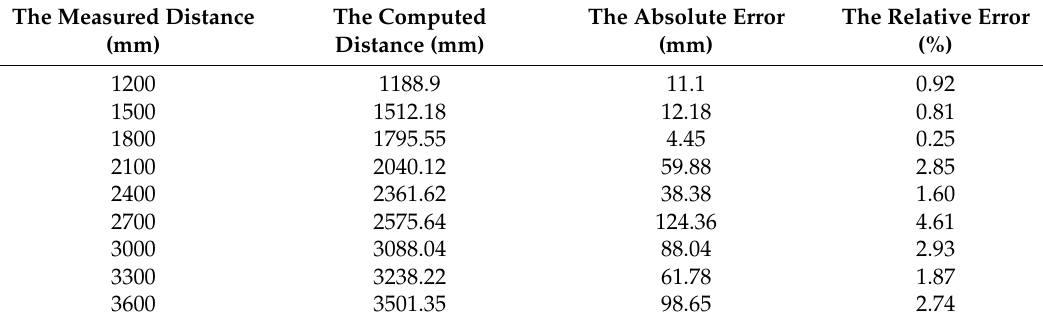
Table 3. The test results of the distances in the heading direction.